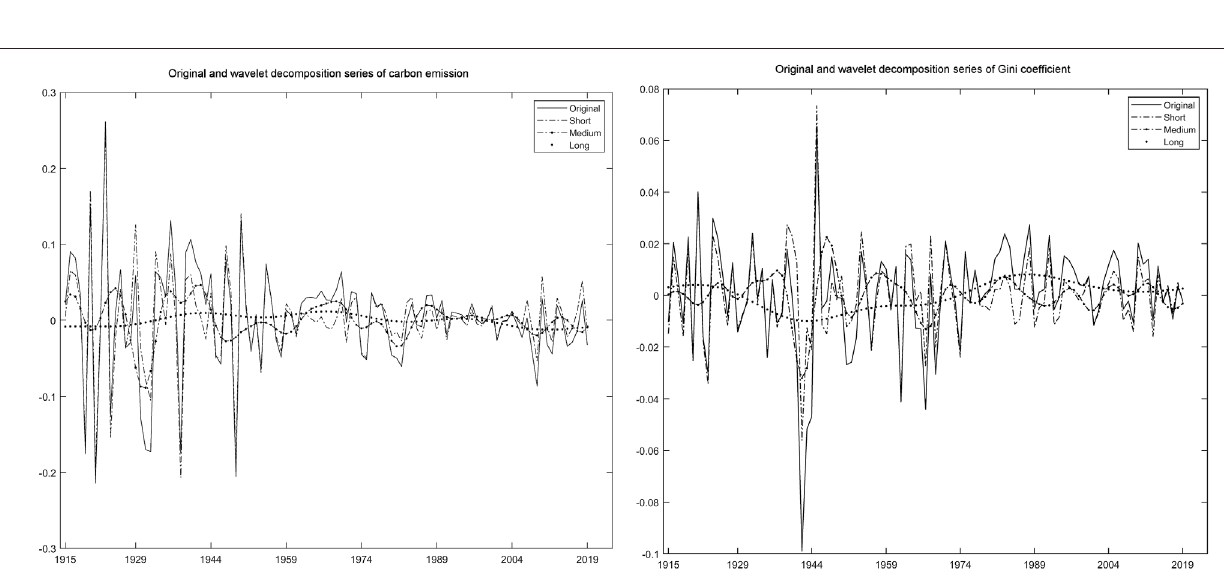
Frontiers in Environmental Science |